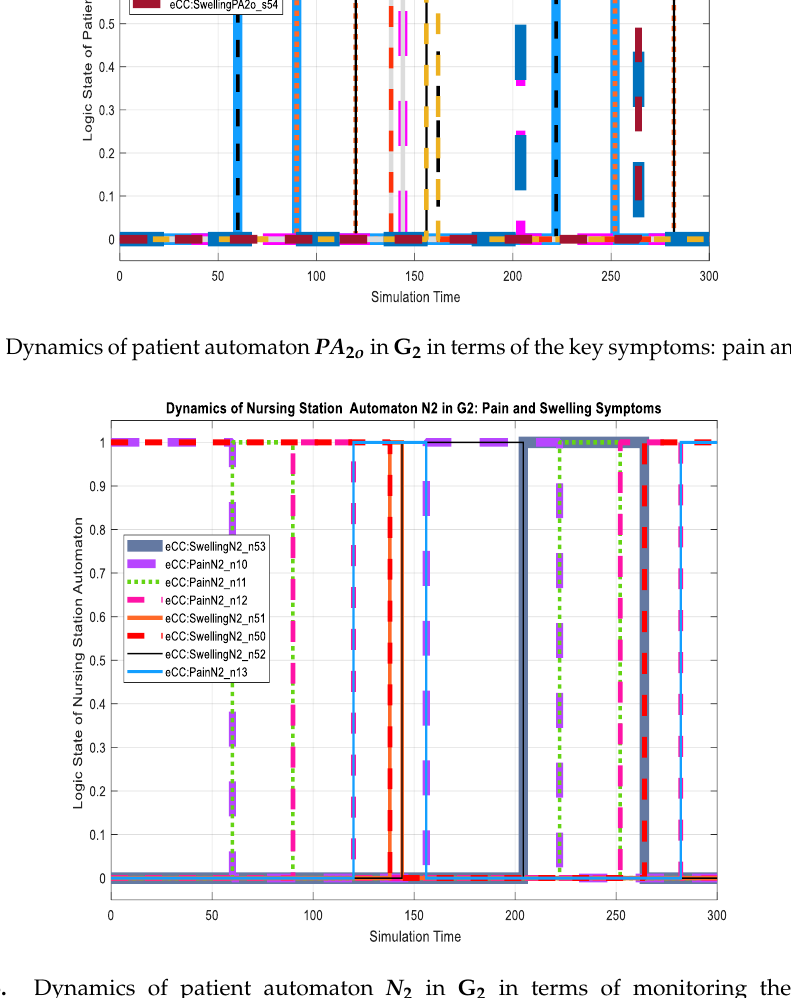
Figure 27. Dynamics of patient automaton 𝑯 𝟐 in 𝑮 𝟐 in terms of monitoring the pain and swelling symptoms.